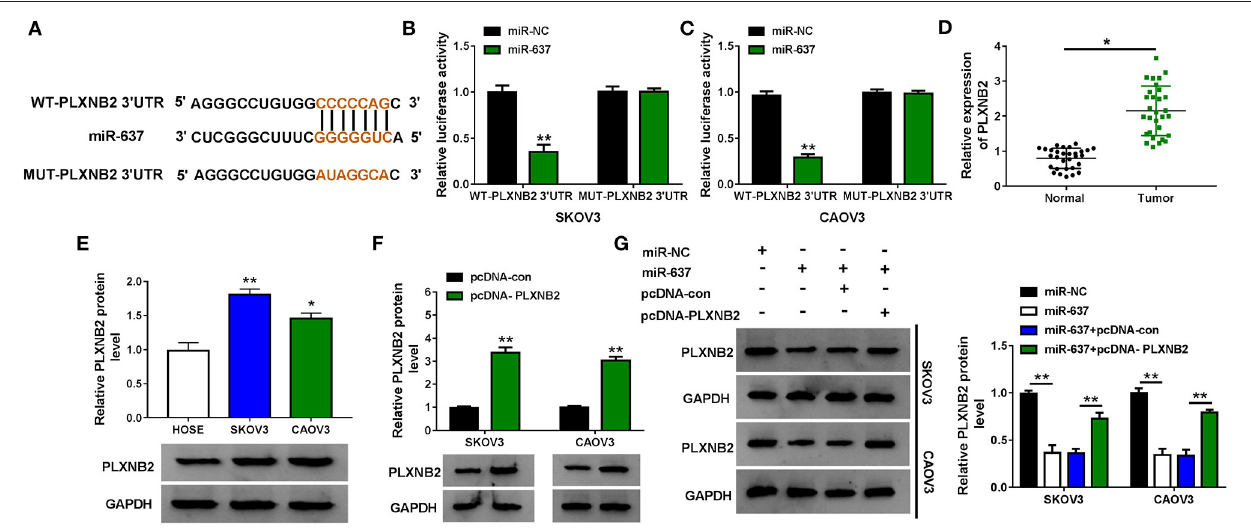
FIGURE 4 | PLXNB2 was a target of miR-637 in OC cells. (A) Binding sites between miR-637 and PLXNB2 3 ′ -UTR were predicted by Targetscan. (B,C) Dual-luciferase reporter assay for the luciferase activity of SKOV3 and CAOV3 cells cotransfected with WT-PLXNB2 3 ′ -UTR or MUT-PLXNB2 3 ′ -UTR and miR-NC or miR-637. (D) QRT-PCR assay for the expression of PLXNB2 mRNA in OC tissues and adjacent normal tissues ( n = 30). (E) Western blot assay for the protein level of PLXNB2 in HOSE, SKOV3, and CAOV3 cells. (F) Western blot assay for the protein level of PLXNB2 in SKOV3 and CAOV3 cells transfected with pcDNA-con or pcDNA-PLXNB2. (G) Western blot assay for the protein level of PLXNB2 in SKOV3 and CAOV3 cells transfected with miR-NC, miR-637, miR-637 + pcDNA-con, or miR-637 + pcDNA-PLXNB2. * P < 0.05; ** P <